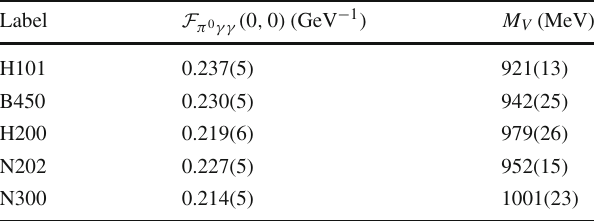
Table 4 The VMD fit parameters of the π 0 transition form factor Label